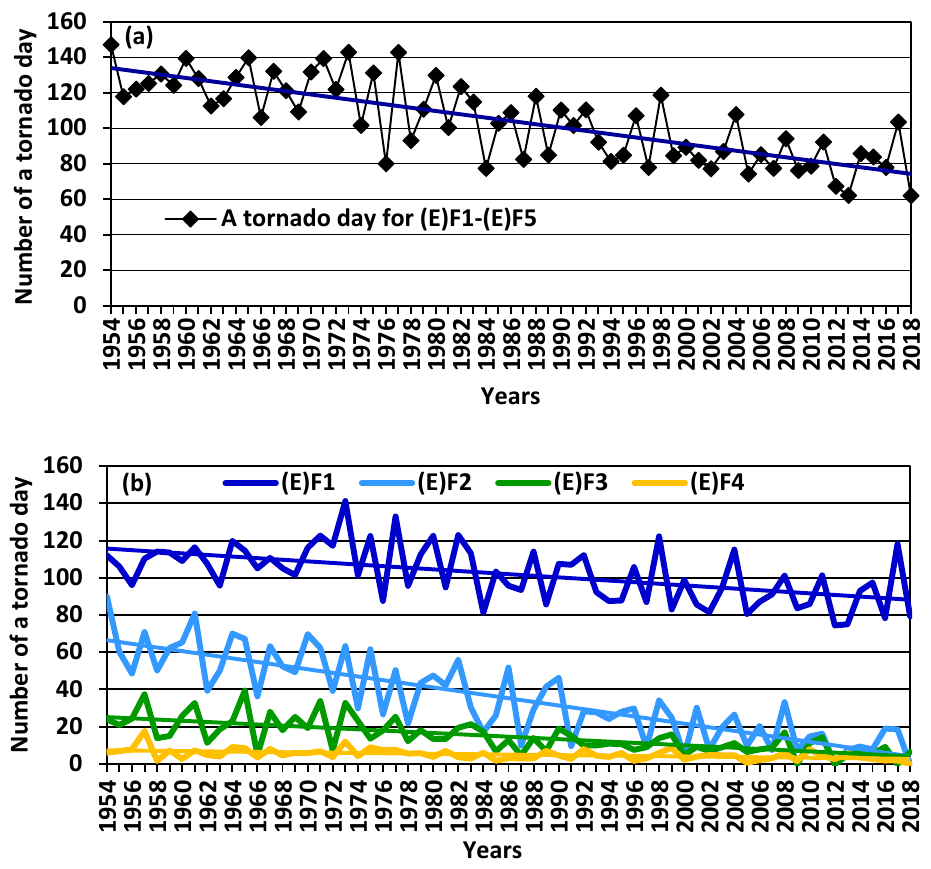
Figure 7. Number of a tornado days (1954–2018) and its trend after removing AR(1) for ( a ) sum. of (E)F1 to (E)F5 tornado days and ( b ) individual (E)F1 to (E)F4 tornado days. For tornado days with a high frequency of occurrence (e.g., 10+, 20+, 30+, 40+, and 50+ tornadoes per day), (E)F1–(E)F5 tornado days have positive trends, in which 10+ and 50+ tornado days pass a statistical test at the level of 95%, and 20+, 30+, and 40+ tornado days pass a statistical test at the level of 99%. For 20+ tornado days, for example, (E)F1–(E)F5 tornado days have a positive trend (Figure 8a) contributed by a positive trend of the (E)F1 tornado day (Figure 8b), and both positive trends are statistically significant at the level of >99%. Our results show that (E)F2, (E)F3, (E)F4, and (E)F5 tornado days are not statistically significant. Similar results were obtained for 10+, 30+, 40+, and 50+ tornado days, with positive trends for both (E)F1–(E)F5 and (E)F1 tornado days at the statistically significant level of >95%. This indicates that the increase of tornado days is toward the high frequency phase, which is mainly contributed by the (E)F1 tornado day. On the other hand, the research in [12] pointed out without statistical tests that the high-frequency tornado days tend to have a higher proportion of stronger tornadoes, such as